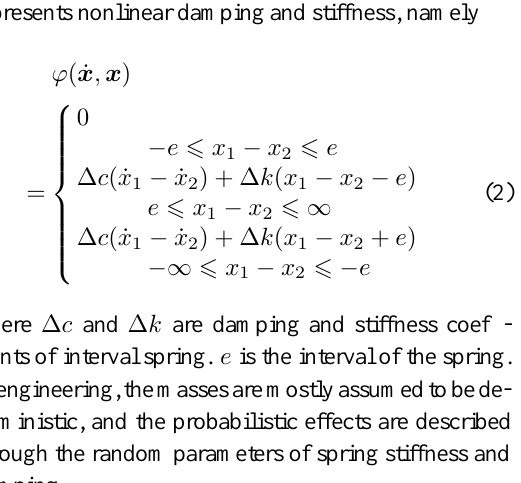
spring stiffness of main vibration system. ω is the fre- quencyof main shaft, r is the eccentricity of main